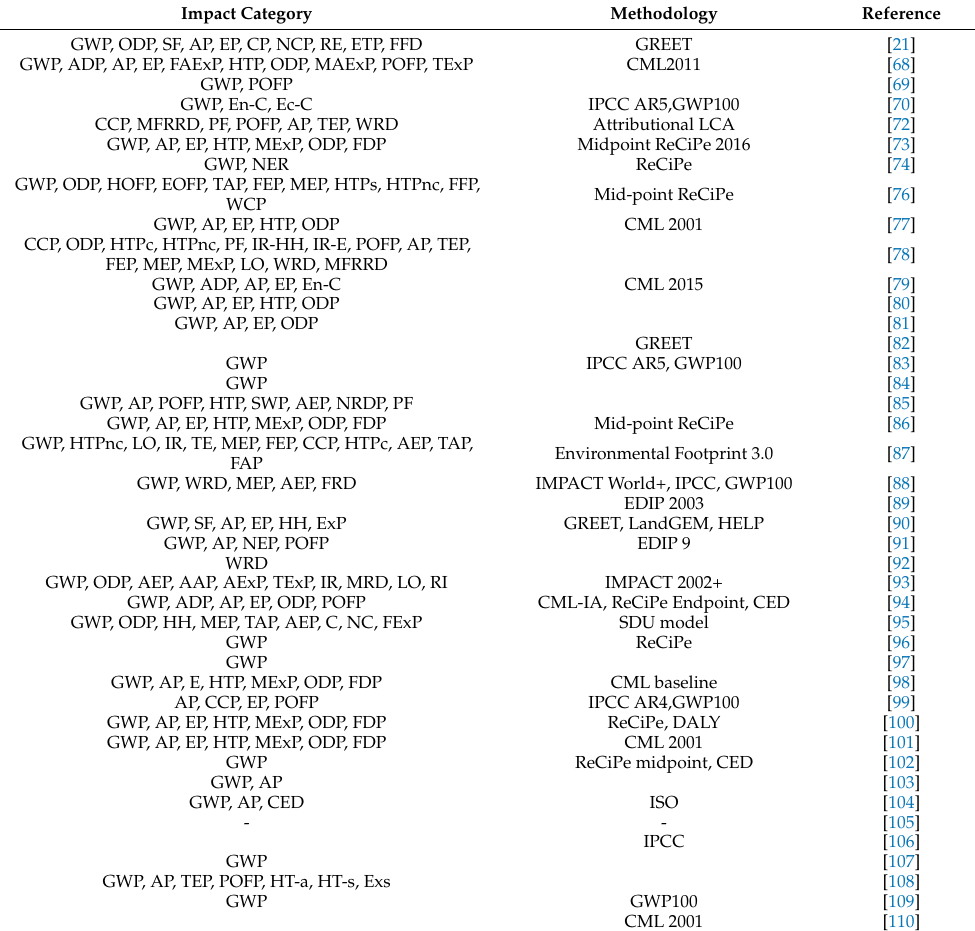
Table 8. Overview of impact categories and life cycle methodology in 42